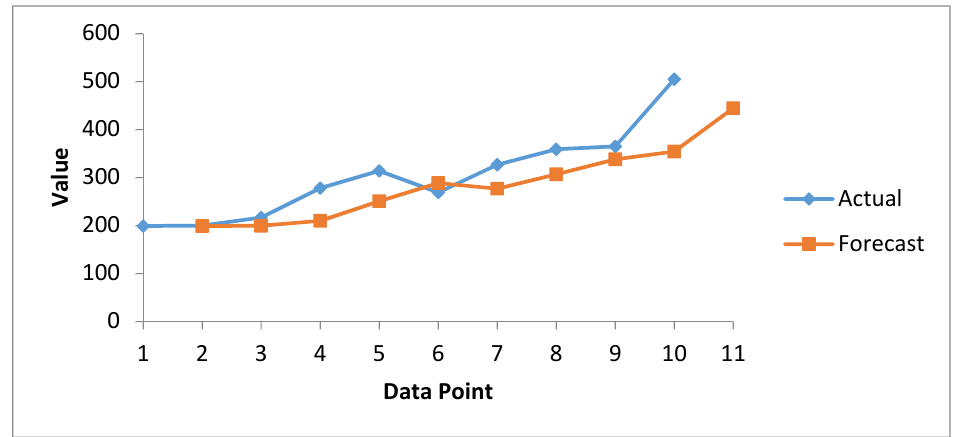
Figure 9. Forecasting Graph of Healthcare Data Breaches from 2010–2020 using the SES method.